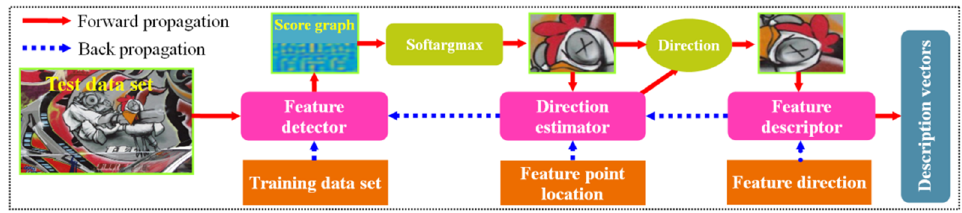
Figure 7. Training and testing of the LIFT pipeline.